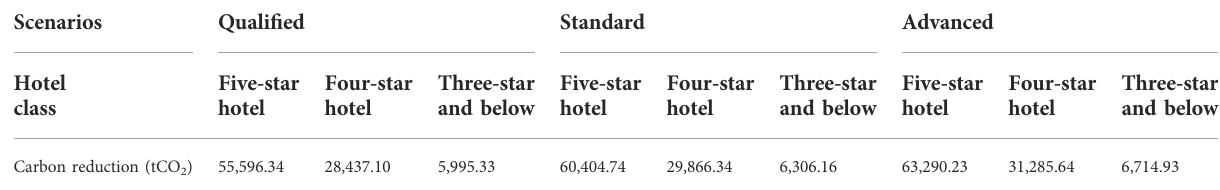
TABLE 7 Emission reductions of single hotel greening under different scenarios.